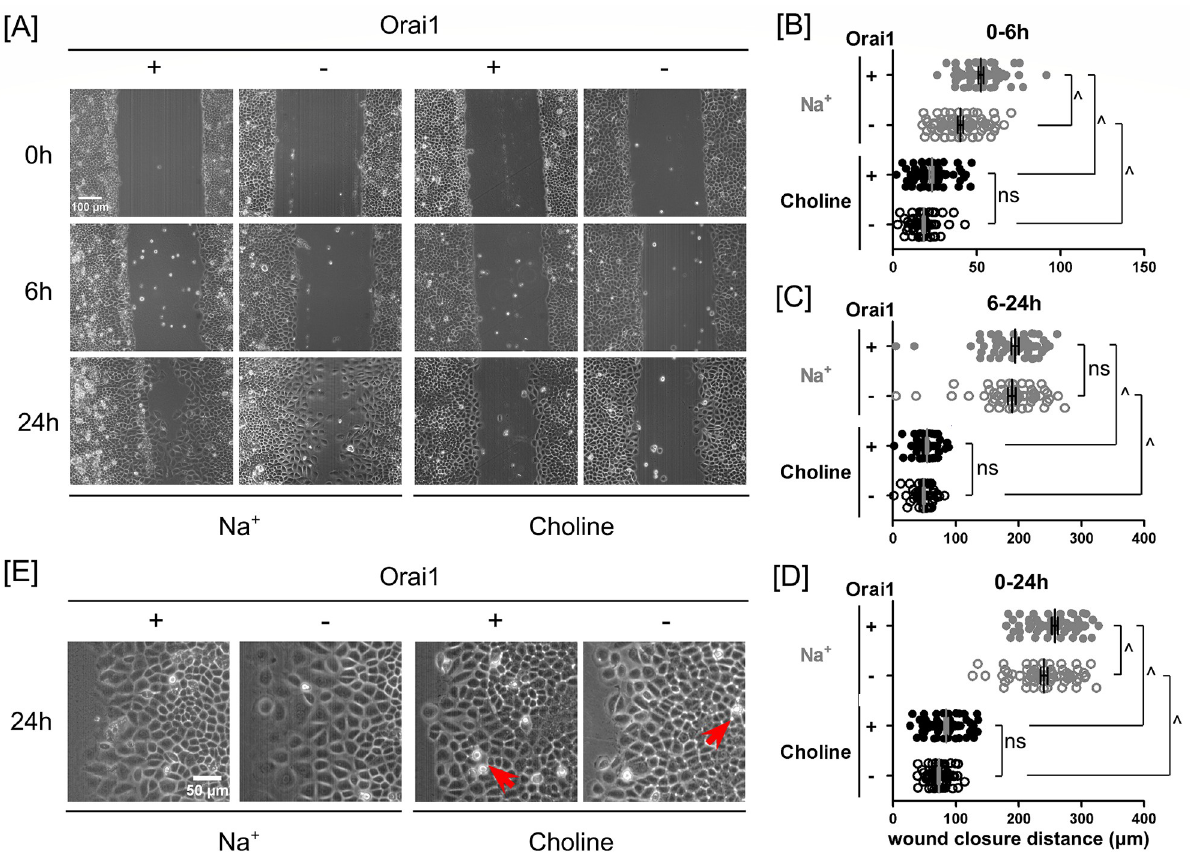
Fig 6. In the presence of extracellular Na + , Orai1 silencing slowed endothelial wound closure. (A) Phase-contrast images of scratched Orai1-expressing and -silenced PA2879 endothelial monolayers at 0, 6 and 24 hours in the presence and absence of extracellular Na + . Scatter plots of wound closure distance in (B) 0–6 hours, (C) 6–24 hours, and (D) 0–24 hours. In the presence of extracellular Na + , wound closure distances in Orai1-silenced PA2979 monolayers were less than the distances in Orai1-expressing monolayers. However, in the absence of extracellular Na + , the contribution of Orai1 was not significant. Data were reported as mean ± SEM. (E) Magnified view of the marginal regions of the Orai1-expressing and -silenced cells at 24 hours of wound closure in Na + - and choline-containing media. Cells near the wound edge spread larger in Na + - than in choline- containing media. Intercellular gaps were observed in the absence of extracellular Na + . Arrows point to typical interendothelial gaps. Statistical significance was assessed using one-way ANOVA with Tukey’s post hoc test (ns—not significant, ^— P <